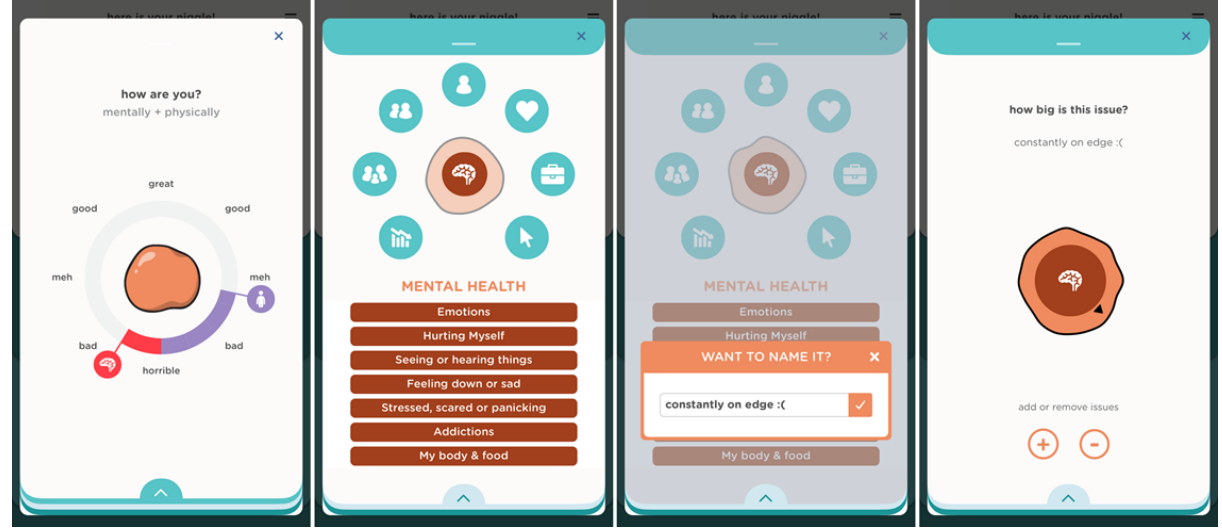
Figure 3. Well-being log, labeling, and resizing the